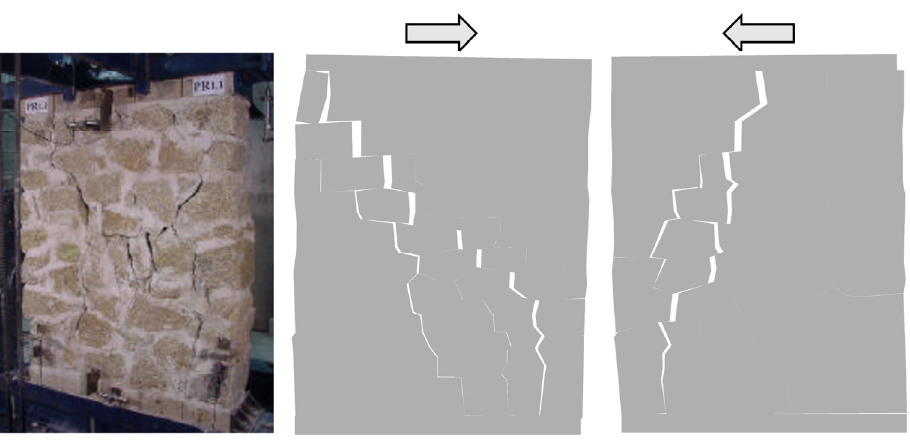
Figure 5. The predicted failure mechanisms of the rubble masonry wall using DEM (the picture on the left is taken from [33]).